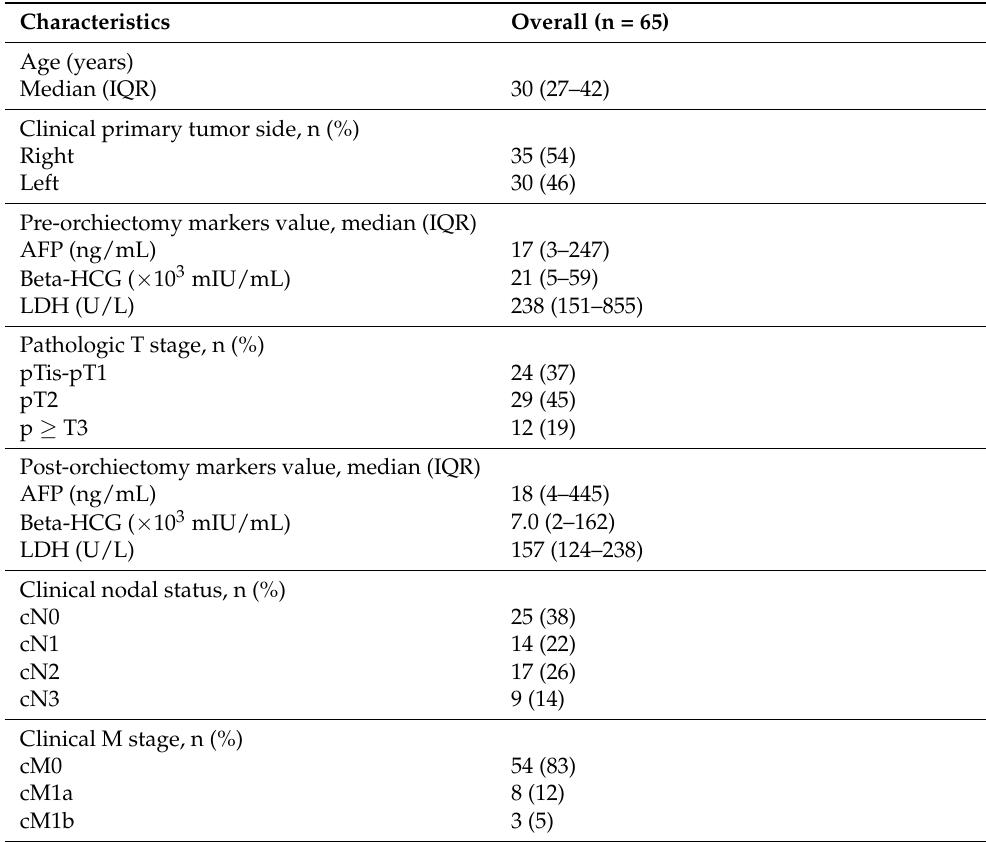
Table 1. Clinical and pathological characteristics of the study population after orchiectomy and prior